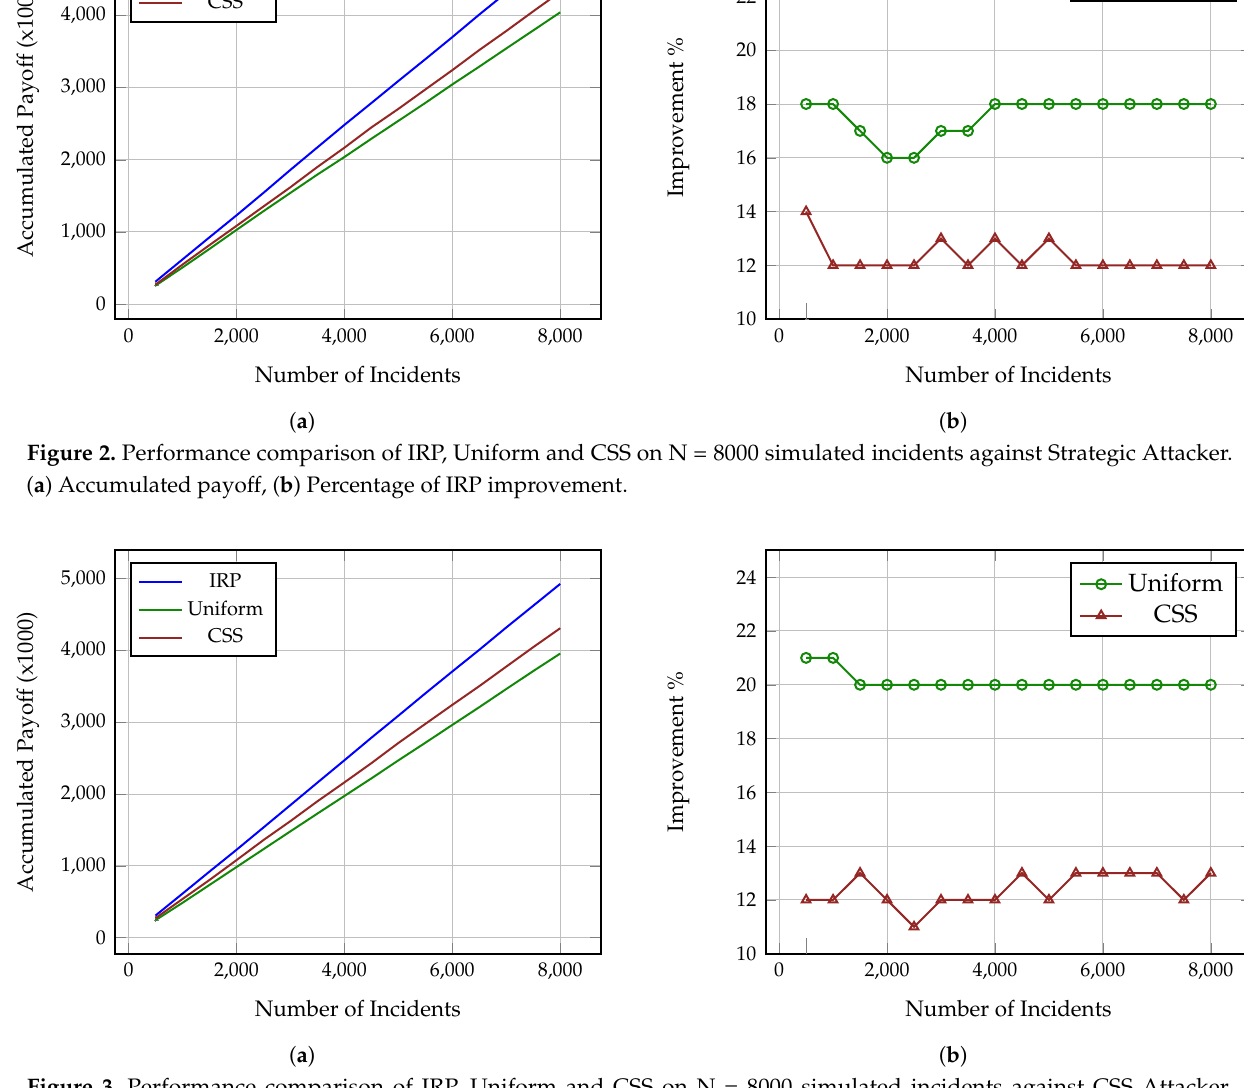
Figure 3. Performance comparison of IRP, Uniform and CSS on N = 8000 simulated incidents against CSS Attacker. ( a ) Accumulated payoff, ( b ) Percentage of IRP